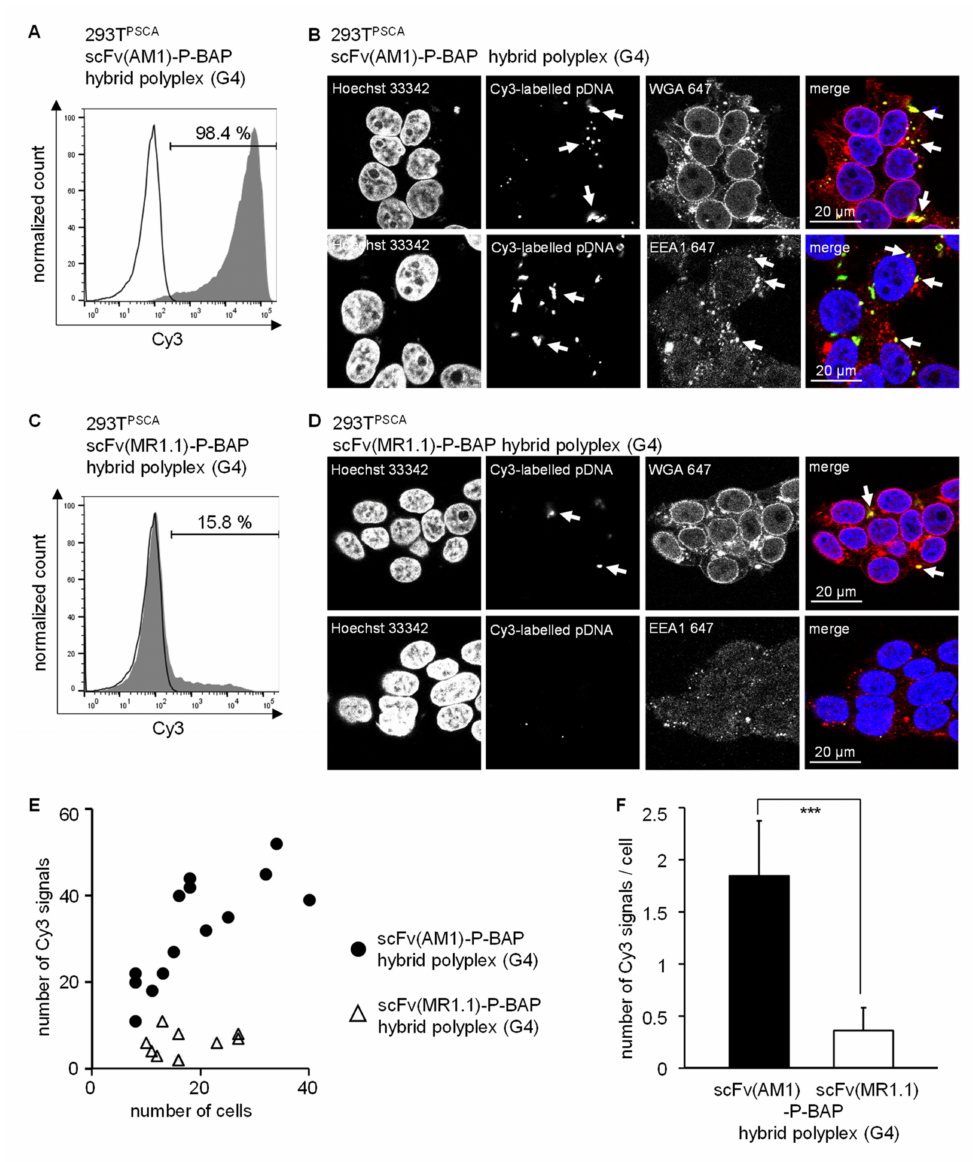
Figure 4. Targeted delivery of scFv(AM1)-P-BAP-guided hybrid polyplexes (G4) in PSCA-positive cells. ( A , C ): 293T PSCA cells were treated with scFv(AM1)-P-BAP or scFv(MR1.1)-P-BAP hybrid polyplexes containing Cy3-labelled plasmid DNA for 4 h (grey histograms). As control, untreated 293T PSCA cells were utilized (open histograms). After Heparin-washing of surface-bound antibodies, the internalized Cy3-labelled plasmid DNA was measured by flow cytometry. ( B , D ): Confocal laser scanning microscopy analysis of 293T PSCA cells treated with scFv(AM1)-P-BAP or scFv(MR1.1)-P-BAP hybrid polyplexes containing Cy3-labelled plasmid DNA. To visualize the route of internalisation, cells were additionally stained with wheat germ agglutinin or early endosomal marker EEA1. Arrows depict Cy3-labelled pDNA or early endosomes. ( E , F ): Quantification of Cy3-labelled pDNA dots per image section or per cell. At least 14 image sections were analyzed (mean ± SD). *** p < 0.001. To investigate if a receptor-mediated endocytosis contributes to uptake of scFv-P-BAP hybrid polyplexes, we blocked clathrin-dependent and clathrin-independent endocytosis using chlorpromazine [29] and filipin III [30]. Both filipin III and chlorpromazine treatment of cells lead to significant decrease in the fraction of GFP-positive 293T PSCA cells when transfected with scFv(AM1)-P-BAP hybrid polyplexes loaded with MC encoding GFP. None of the used endocytosis inhibitors completely blocked transfection of GFP,